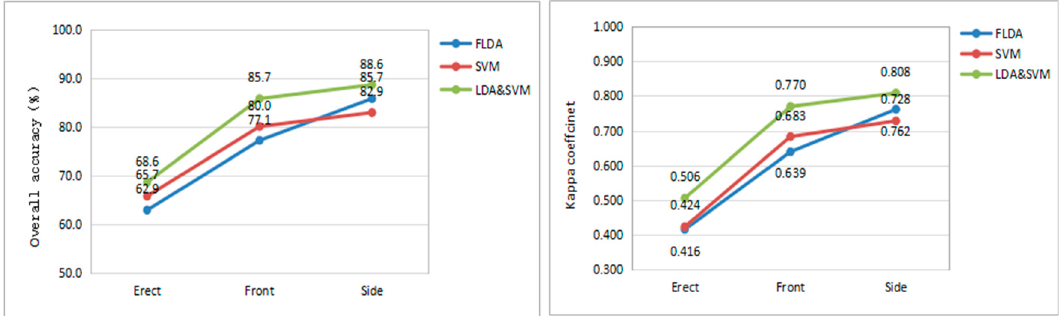
Figure 6. Comparison curve of model accuracy and kappa coefficient.